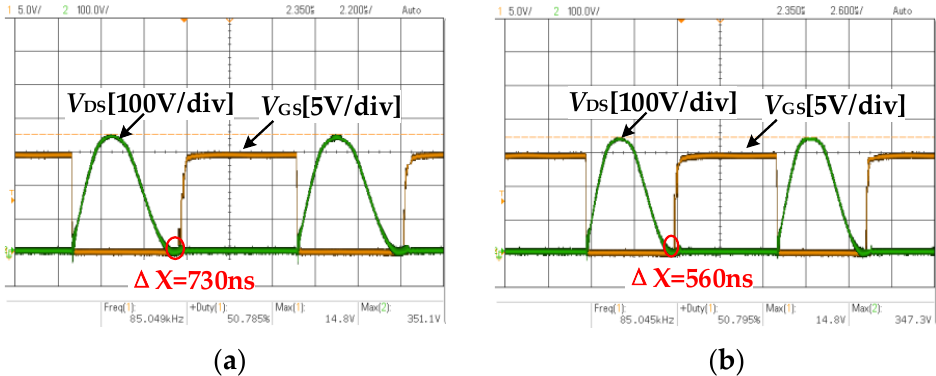
Figure 20. ZVS waveforms under the minimum and maximum load conditions. ( a ) ZVS waveform of Q when R L = 6 Ω; ( b ) ZVS waveform of Q when R L = 24 Ω.